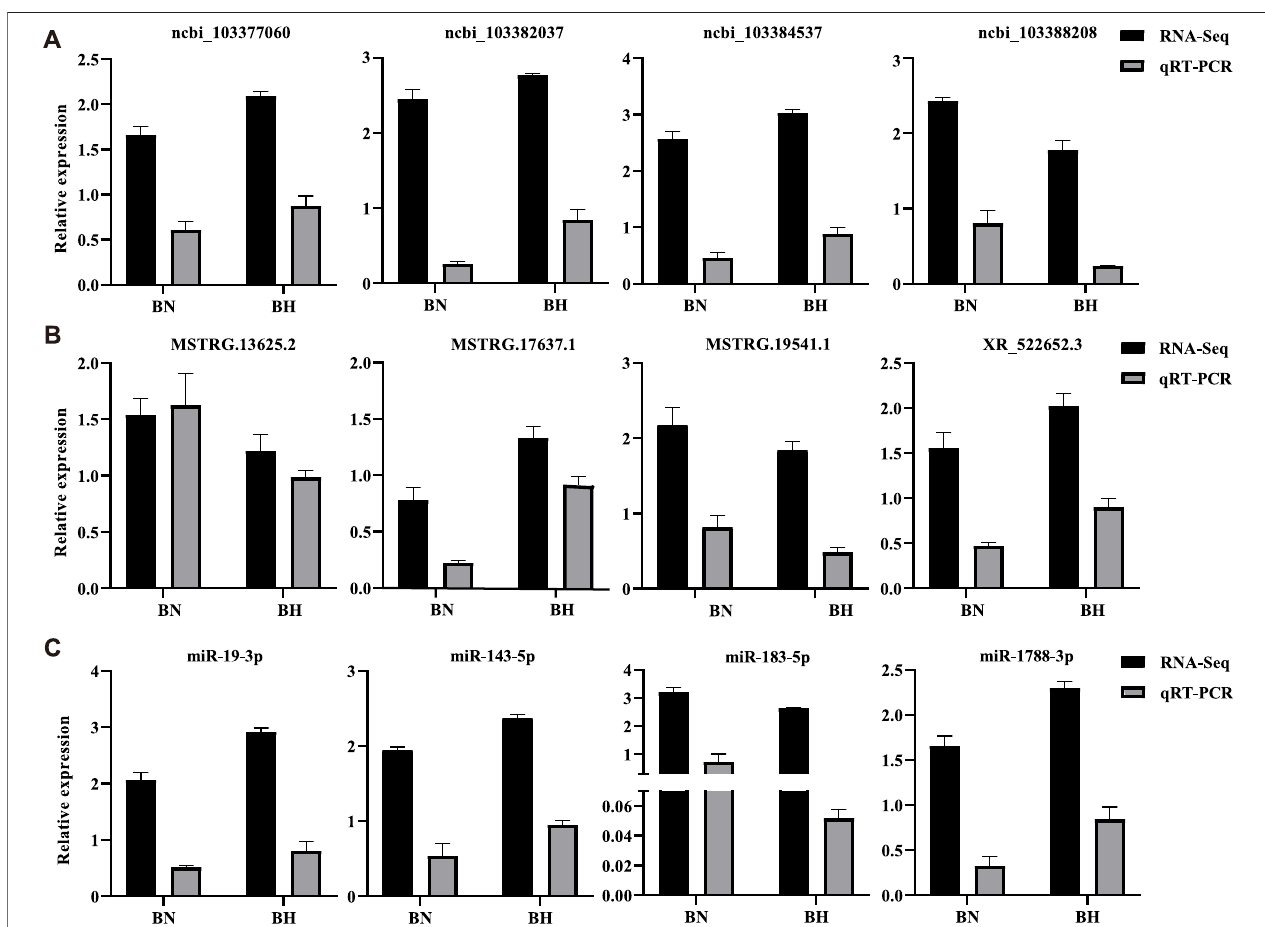
FIGURE 8 | Real-time quantitative reverse transcription polymerase chain reaction (qRT-PCR) validation results of mRNAs, lncRNAs, and miRNAs. (A) Relative expression levels of four randomly selected DEGs from RNA-Seq and qRT-PCR. (B) Relative expression levels of four randomly selected differentially expressed lncRNAs from RNA-Seq and qRT-PCR. (C) Relative expression levels of four randomly selected differentially expressed miRNAs from RNA-Seq and qRT-PCR. Bars indicate standard errors.